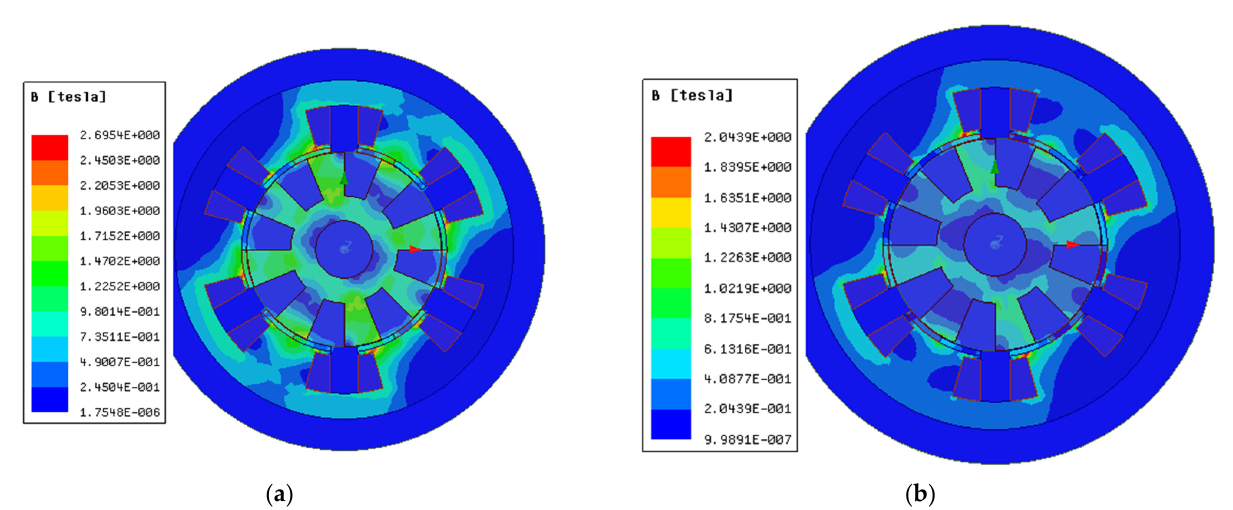
Figure 6. Rated load flux density plot of 10 kW FRGs: ( a ) RE-FRG and ( b ) NRE-FRG.